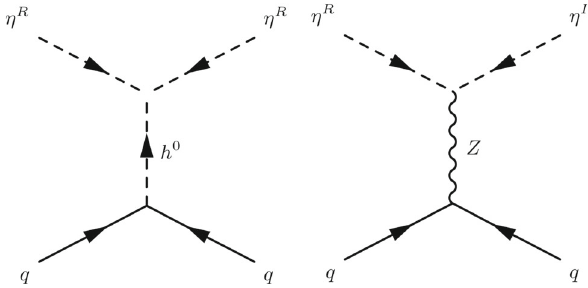
Fig. 12 Tree-level diagrams contributing to the elasticscatteringof η R off nuclei via the Higgs exchange (left) and Z 0 -boson exchange